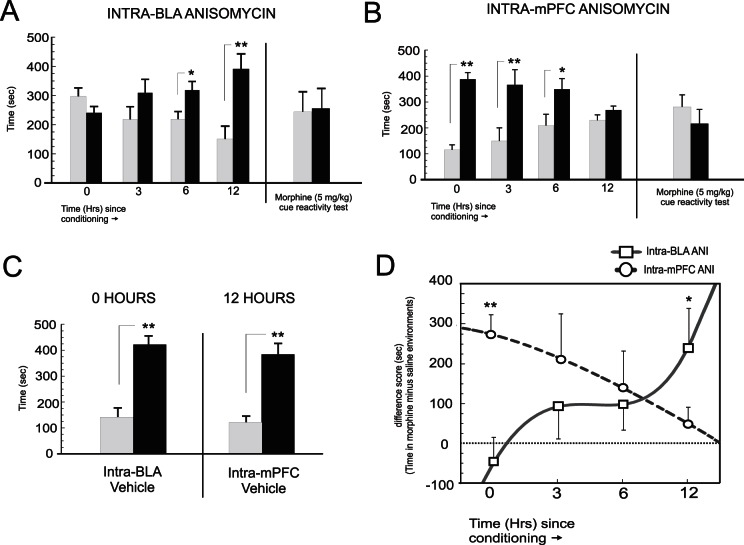
Effects of intra-BLA or mPFC anisomycin on temporal consolidation of acute opiate reward memory.
A, Post-conditioning intra-BLA microinfusions of ANI completely block consolidation of opiate reward memory when administered at 0 and 3 hrs, but has no effect at 6 or 12 hrs. A Morphine cue-recall control test administered 24 hrs after the initial CPP test in the 0 hr group does not re-store the memory. B, Post-conditioning intra-mPFC microinfusions of ANI completely block consolidation of opiate reward memory when administered at 12 hrs, but has no effect at time-points before this. A morphine cue-recall control test administered 24 hrs after the initial CPP test in the 12 hr group does not re-store the memory. C
, Vehicle control groups for the effective time points of 0 hrs (intra-BLA) or 12 hrs (intra-mPFC) caused no block of morphine reward CPP memory consolidation. D, Temporally divergent effects of opiate reward memory consolidation interference presented as CPP difference scores (calculated as times in drug minus vehicle-paired environments).